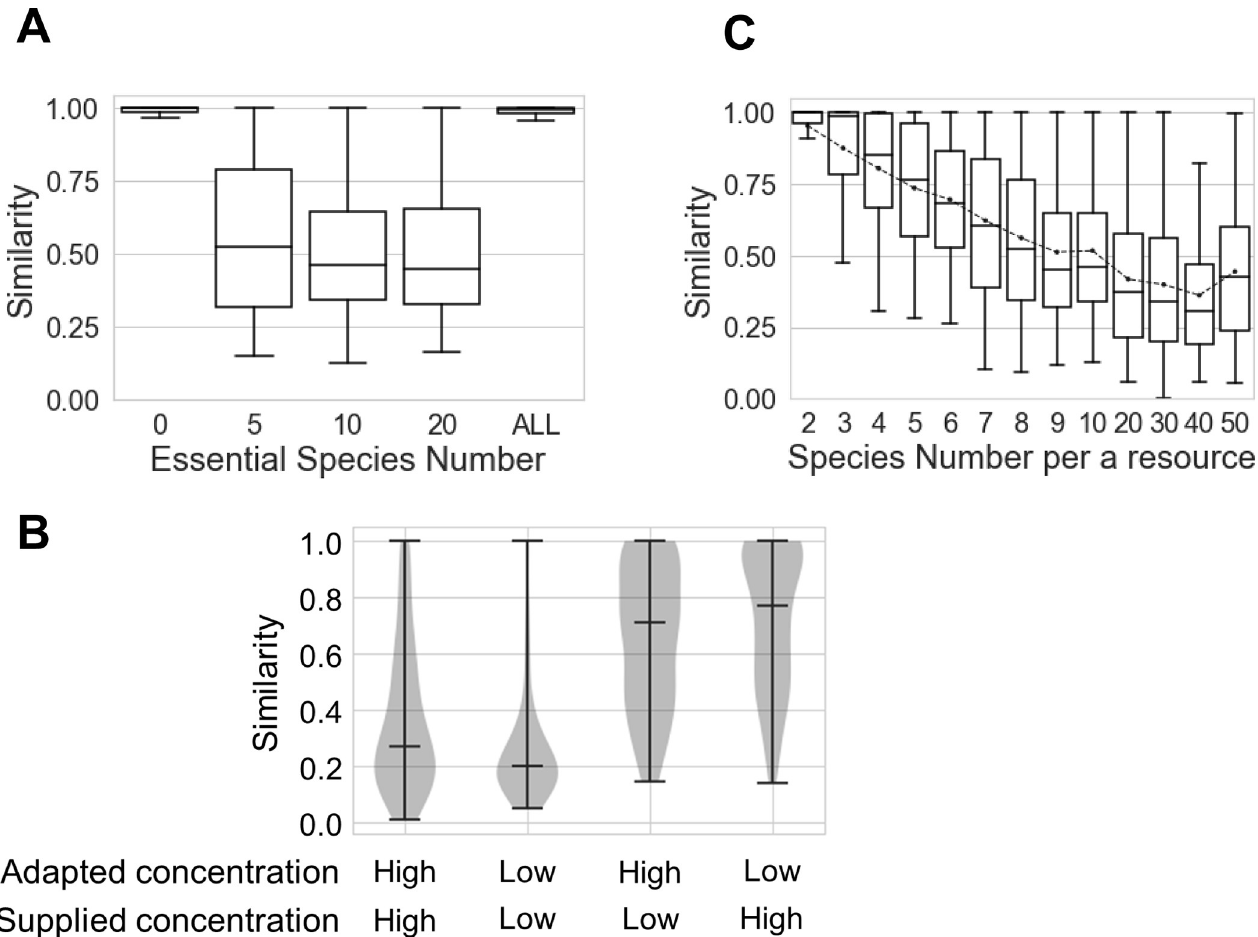
Fig 3. Stochasticity of in silico microbial community assembly. A. The number of essential-microbial species for each species varied in the community consisting of 10 resources and 100 microbial species, where each resource was specialized in 10 microbial species. B. Microbial communities adapted to a high/ low concentration resource were supplied with a high/low concentration resource. Horizontal lines in the violin plot represent the maximum, minimum, and median values of similarity. C. The number of microbial species specializing in each resource varied. The number of resources is 10; therefore, for example, species number 2 means the community consists of 20 microbial species. Dots in boxes represent the mean of